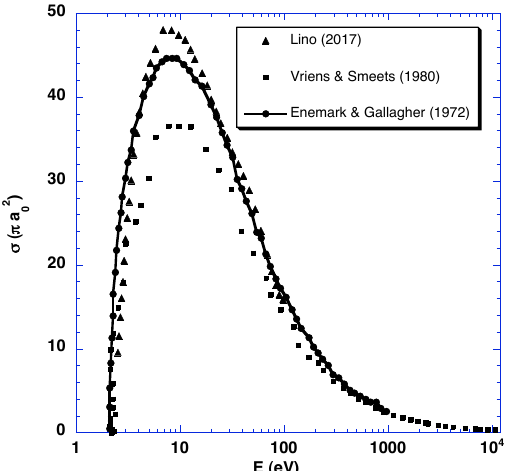
Figure 1. Excitation cross-sections σ lu (in π a 2 energies E (eV) up to 10 4 eV. [15,22,25].